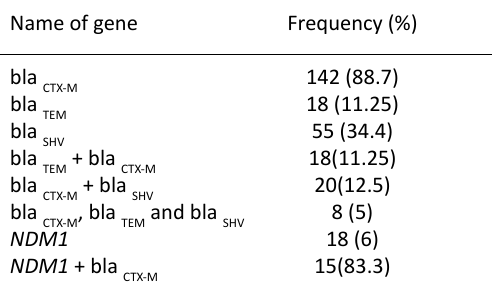
Table 8. Frequency of extended-spectrum beta-lactamase genes (n=160) and NDM1 gene (n=300), isolated in E. coli